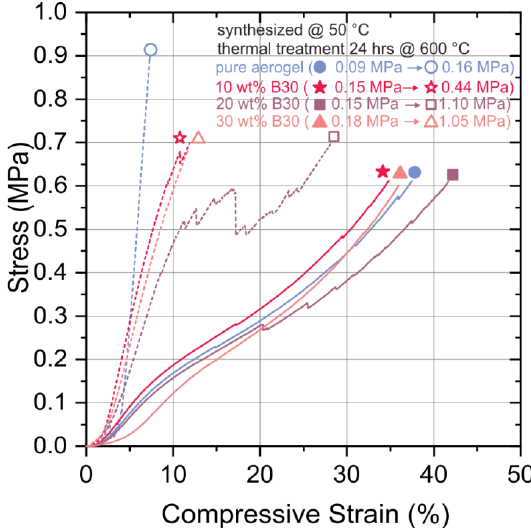
Figure 3. Compression curves of the pure SA (circle; blue line) and SAs combined with different concentrations of B30 before (full line and symbols) and after heat treatment (dashed line and empty symbols). All the specimens were synthesized at 50 °C.